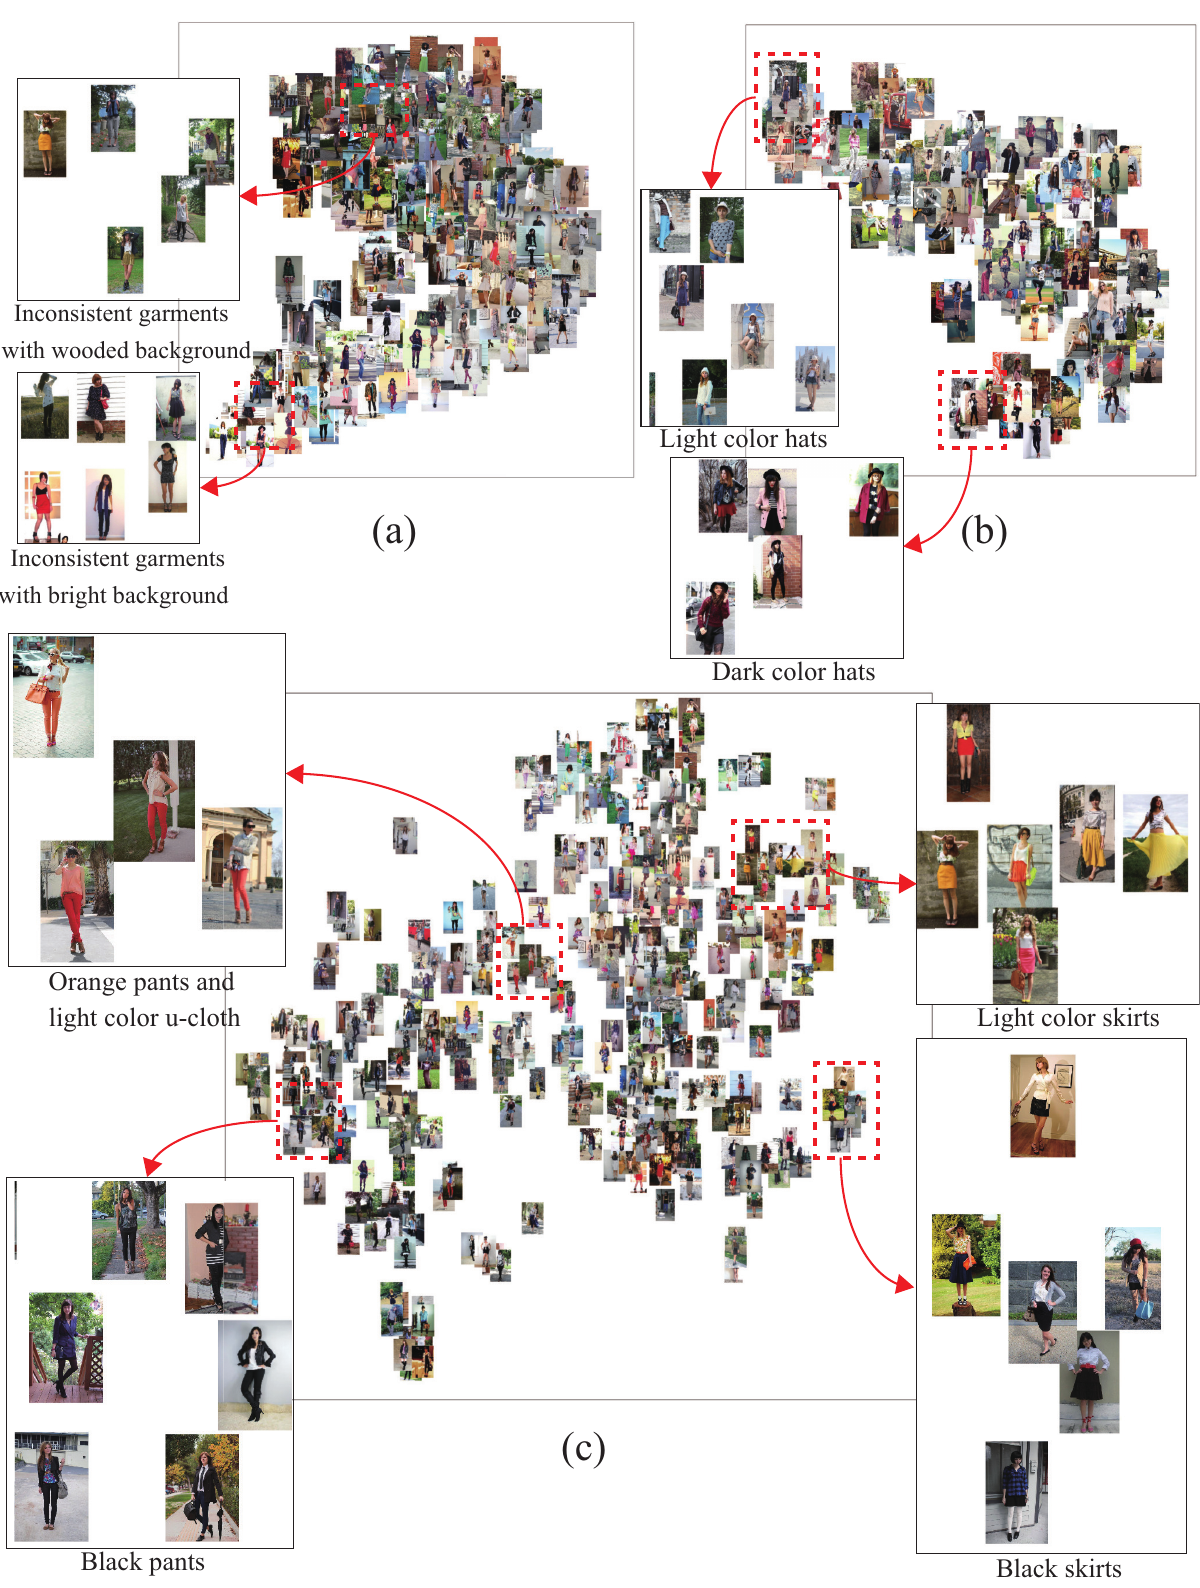
Fig. 7 Visualization of human-image data for fashion style analysis by t-SNE [29], on the basis of features (a) from the entire region (i.e., without any labels specified), (b) with hat label, and (c) with pants, skirt, and u-cloth